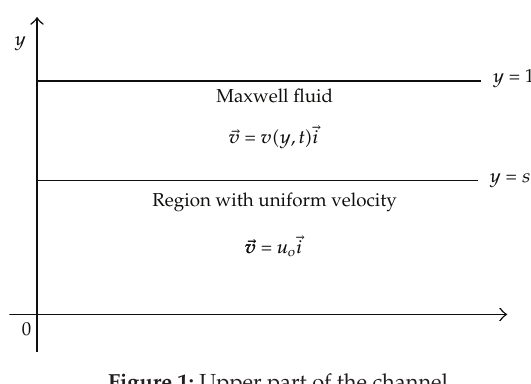
Figure 1: Upper part of the